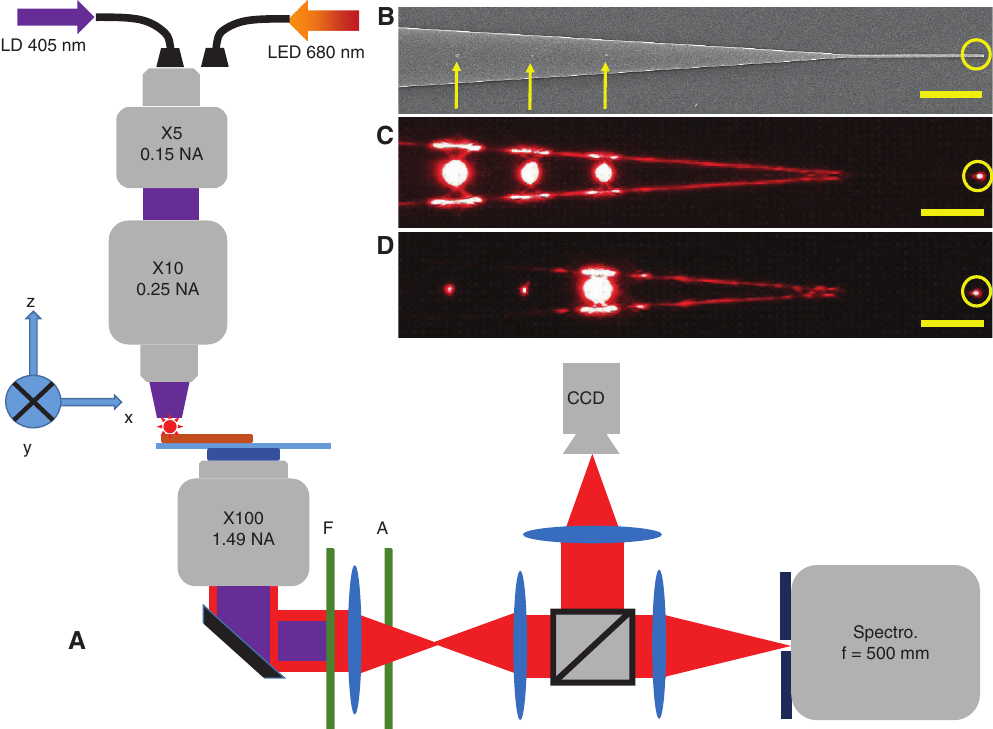
Figure 7: (A) Optical characterization set-up (F: high-pass filter, A: polarization analyzer). (B) SEM image of a tapered waveguide with three sources placed at the locations indicated by the yellow arrows. (C) [resp. (D)] fluorescent image recorded with the CCD camera in the case of collimated (resp. focused) optical pumping (at 405 nm) of the sources. The scattering spot (highlighted by a yellow circle) at the end of the waveguide demonstrates fluorescent light coupling into the waveguide. [Scale bar = 10 μ m on (B), (C), and